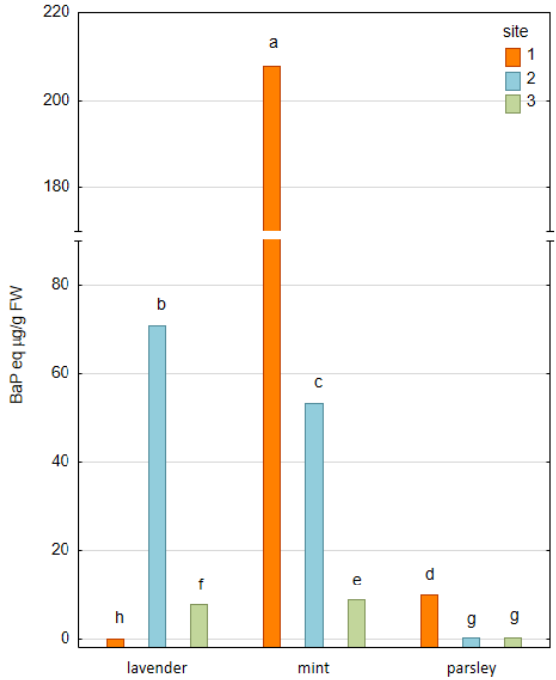
Figure 2. The content of benzo[a]pyrene equivalent (BaP eq ) in plant material expressed as average ( n = 3) (values denoted with identical letters do not differ significantly at p = 0.05 according to the post-hoc test, following two-way ANOVA for the ‘site × species’ fixed effect; FW—fresh weight). The US EPA has classified 16 polycyclic aromatic hydrocarbons as